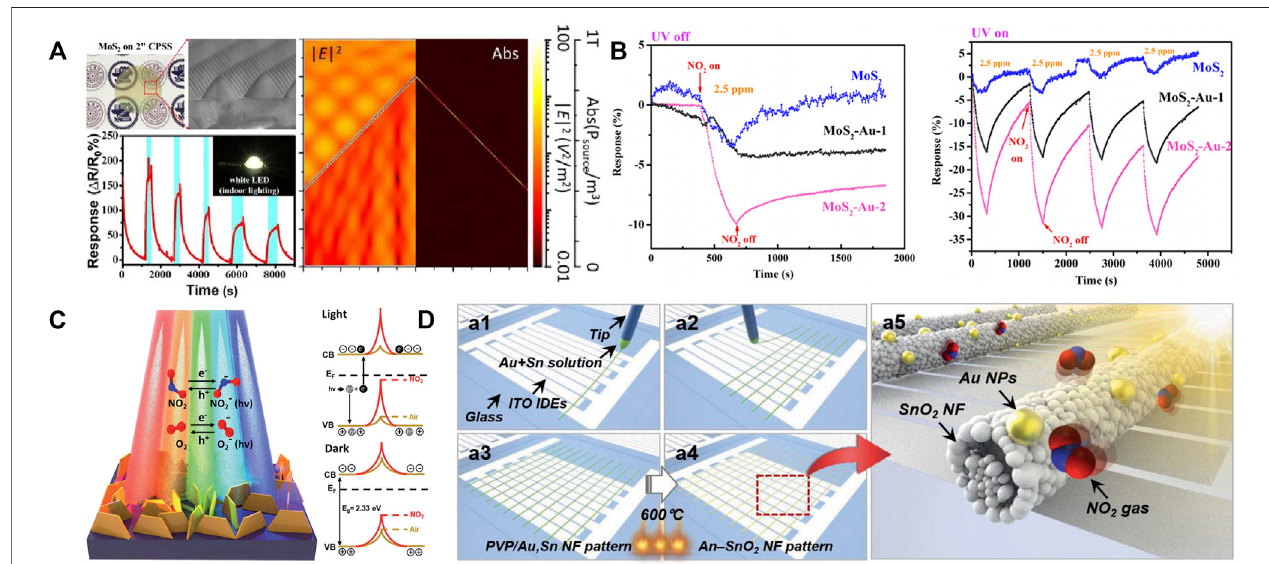
FIGURE 1 | (A) Microscopic characterization of MoS 2 and gas sensing performance under white light, Simulation results for the Flat-MoS 2 and Cone-Shaped- MoS 2 gas sensors by fi nite difference time domain (FDTD) illuminated by the light with the wavelength of 550 nm. Reproduced with permission from ref. 13. Copyright 2019,RoyalSocietyofChemistry. (B) Schematicillustrationsofedge-enrichedSnS 2 NFsforvisiblelightactivatedNO 2 gassensor.Reproducedwithpermissionfromref. 14. Copyright 2021, Royal Society of Chemistry. (C) Sensing performance of MoS 2 and MoS 2 -Au sensors toward NO 2 gas with no UV illumination. Reproduced withpermissionfromref.17.Copyright2018,AmericanInstituteofPhysics. (D) Schematicillustrationfor(left)theexperimental procedurestofabricatenano fi berpattern (NF-P) sensors via near- fi eld electrospinning (NFES) and (right) NO 2 detection of nano fi ber pattern (NF-P) sensors under visible light illumination. Reproduced with permission from ref. 18. Copyright 2021,